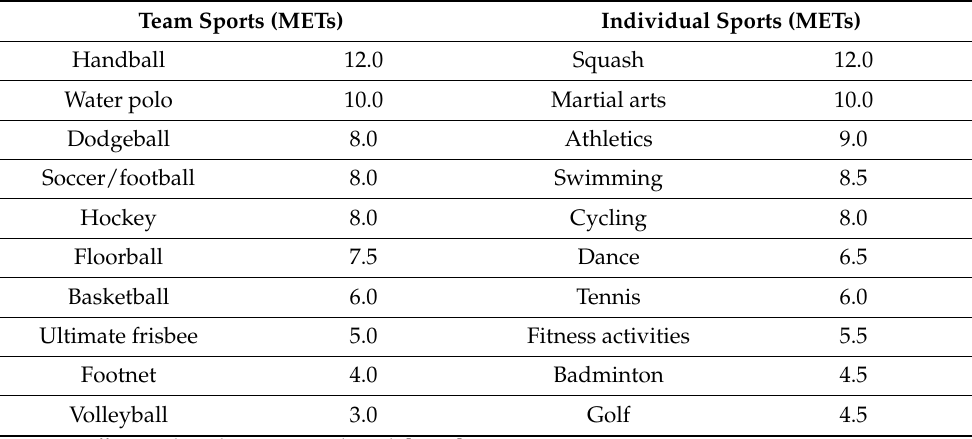
Table 1. Sports activities–division cut-off points.